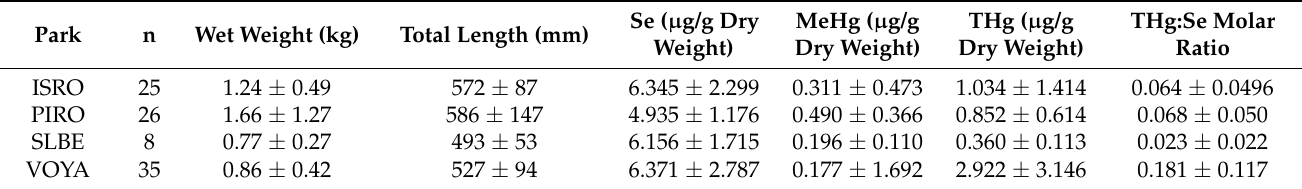
Table 2. Characteristics (mean ± SD) of northern pike collected from Isle Royale National Park (ISRO), Pictured Rocks National Lakeshore (PIRO), Sleeping Bear Dunes National Lakeshore (SLBE), and Voyageurs National Park (VOYA).